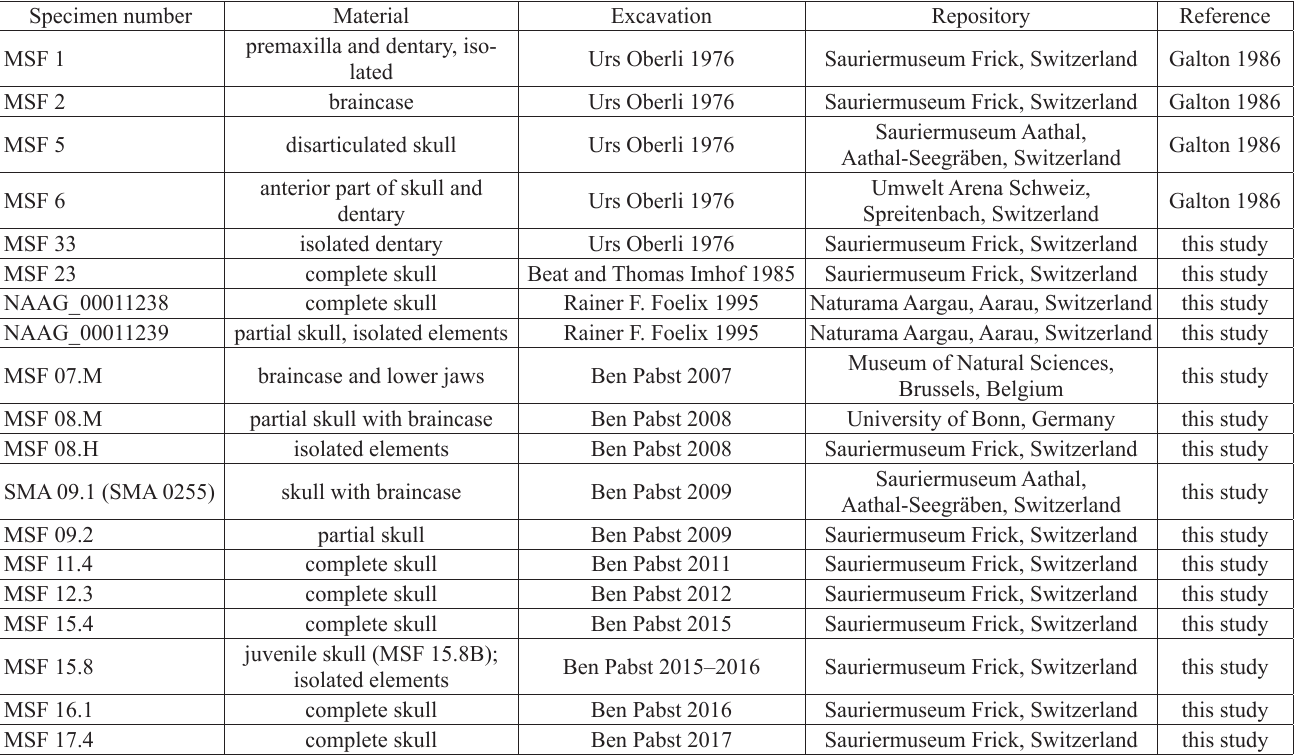
Table 1. Plateosaurus skull material from the lower and middle “saurian levels” of Frick,